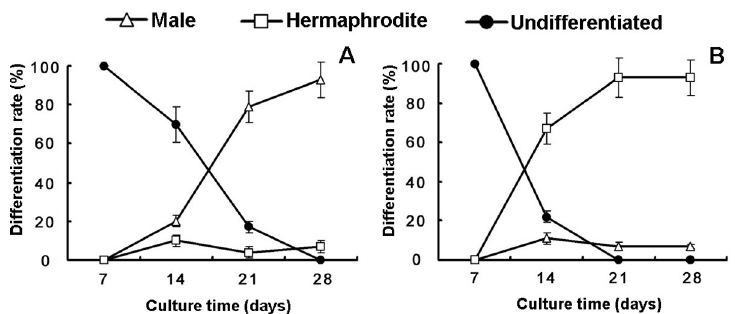
Fig 1. The sex expression of C . thalictroides gametophytes. (A) Cultures grown on Knop’s medium; (B) Cultures grown on MS medium. Three replicates were used for each sample. The bars represent the mean ± SD.